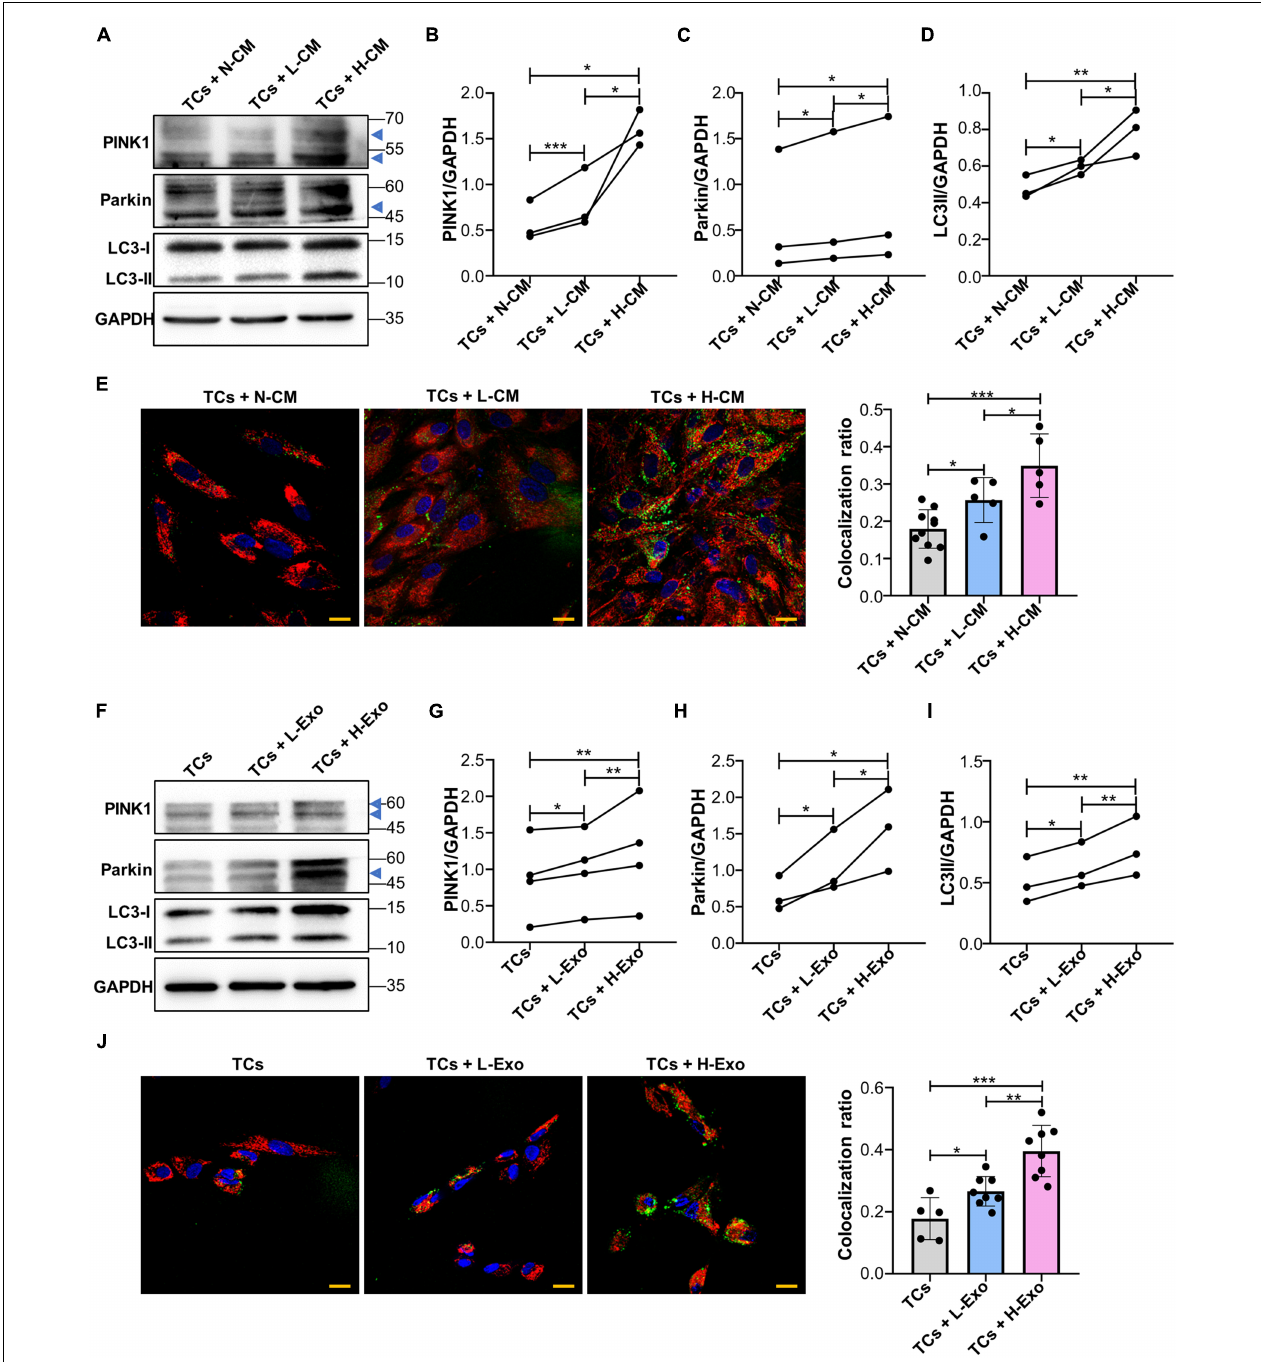
FIGURE 3 | Single-cell colonies with high osteogenic ability activated PINK1/Parkin-mediated mitophagy in TCs through exosomes. (A–D) Proteins associated with PINK1/Parkin-mediated mitophagy in the TCs stimulated with N-CM, L-CM, and H-CM were tested by western blot and quantified using ImageJ ( n = 3). (E) The colocalization of mitochondria and lysosomes in the TCs was assessed by fluorescence microscopy after 5 days of stimulation with N-CM, L-CM, or H-CM ( n = 10, 5, and 5, respectively). Red, mitochondria; green, lysosomes; blue, nucleus. (F–I) Proteins associated with PINK1/Parkin-mediated mitophagy in the TCs stimulated with the cluster medium only, cluster medium with L-Exo, or cluster medium with H-Exo for 5 days were tested by western blot and quantified using ImageJ ( n = 3 or 4). (J) The colocalization of mitochondria and lysosomes in the TCs stimulated with the cluster medium only, cluster medium with L-Exo, or cluster medium with H-Exo for 5 days was assessed by fluorescence microscopy ( n = 5, 8, and 8, respectively). Red, mitochondria; green, lysosomes; blue, nucleus. CM, conditioned medium; TCs, target cells; N-CM, normal culture medium; L-CM, conditioned medium from L-SCCs; H-CM, conditioned medium from H-SCCs; L-Exo, exosomes secreted by L-SCCs; H-Exo, exosomes secreted by H-SCCs; the blue triangle represents the expected band for PINK1 or Parkin. Scale bar, 20 µ m. * P < 0.05; ** P < 0.01; *** P < 0.001.